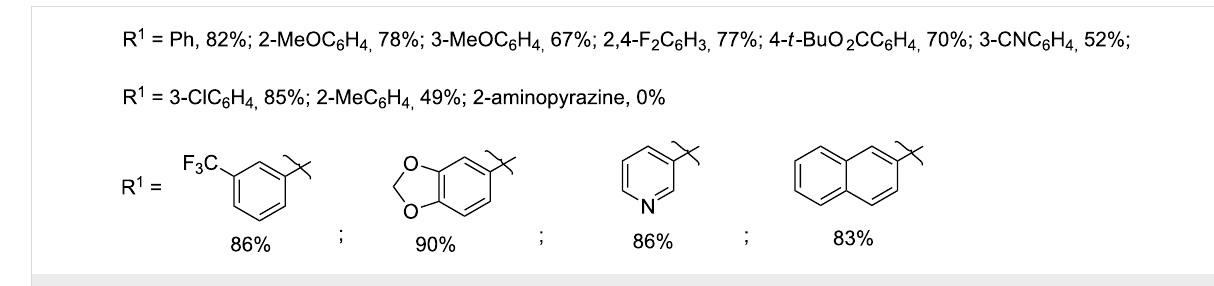
Figure 5: Scope of aniline